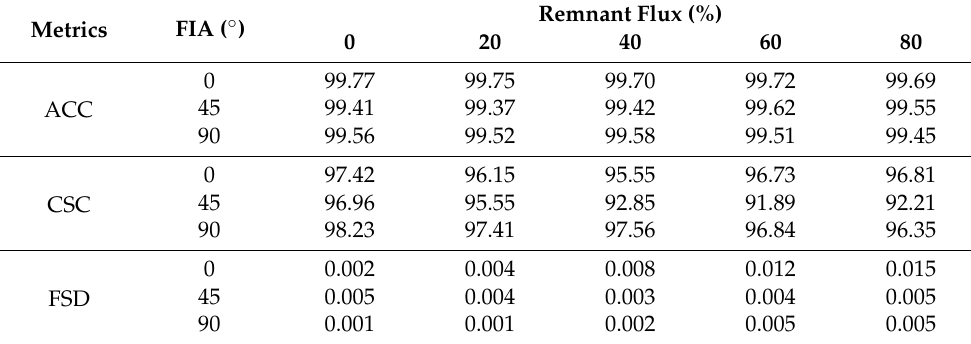
Figure 10. The detection result of CT saturation on the 154-kV (FIA of 45 0 , and remnant flux of 80%). ( a ) Saturated and non-saturated waveform; ( b ) Detection signals. Table 3. Metrics measured from DNN for the 154kV system.